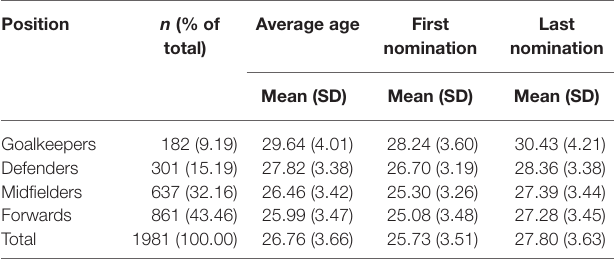
TABLE 1 | Age at nomination across playing positions for the total